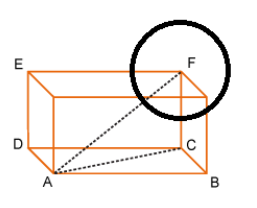
Figure 12. Pythagoras’ theorem for 3D